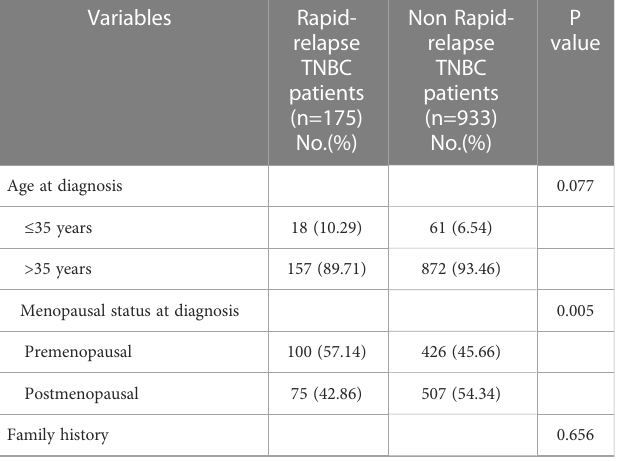
TABLE 3 Risk factors of rapid relapse in training set according to strati fi ed variables: univariate analysis.